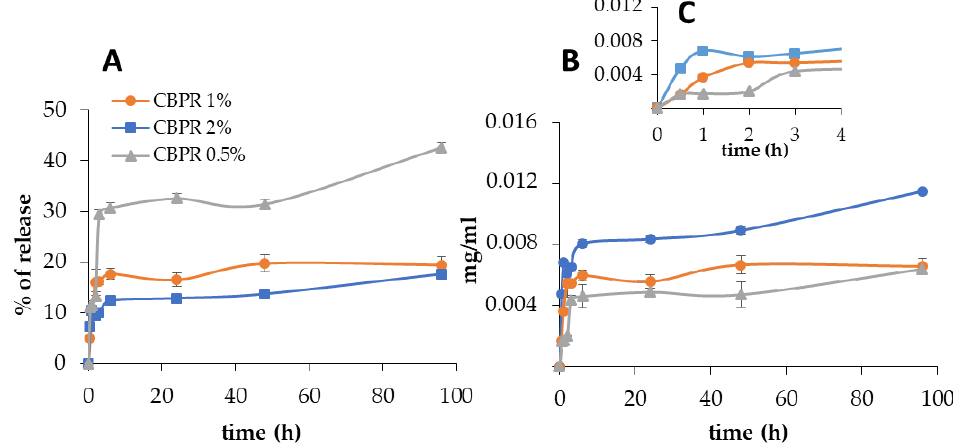
Figure 5 . In vitro bud poplar resin release from CBPR films. Data are expressed as percentage of release ( A ) and as relative mg/mL of bud poplar resin extract in the release medium ( B ) with inset first 4 h of test ( C